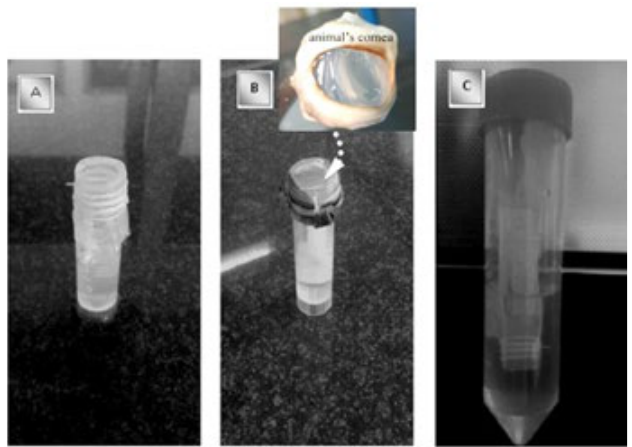
FIGURE 2 - The acceptor compartment for drug release (A), the acceptore compartment for penetration studies (B), receptor compartment